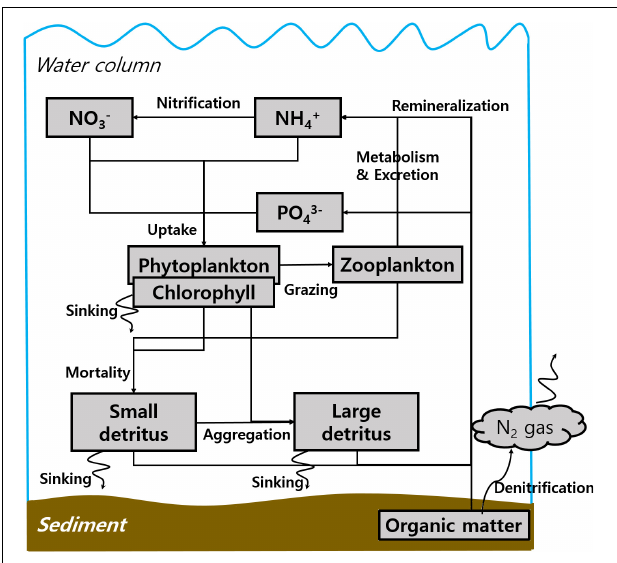
FIGURE 3 | A biogeochemical model schematic for the nitrogen and phosphorus cycles based on Fennel et al. (2006) and Gan et al. (2014).